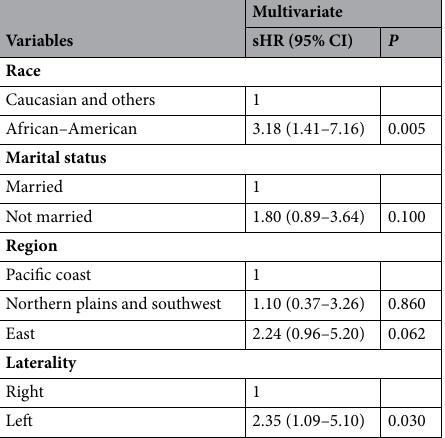
Table 3. Competing risks regression for heart-related mortality in patients aged ≤ 50 years. sHR: subdistribution hazard ratio; CI: confidence